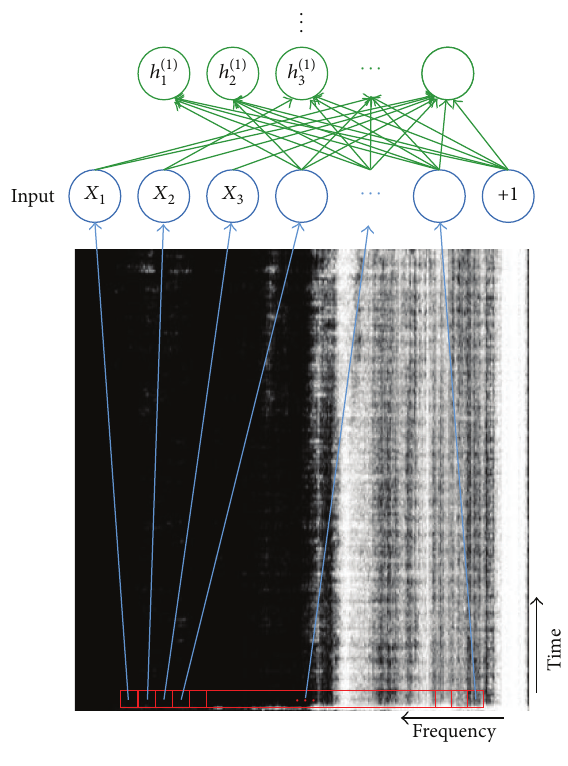
Figure 15: Data selection method. Table 7: Fault identification results using EMD-TEO.